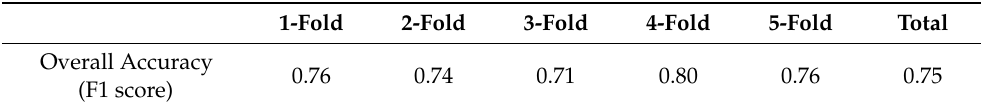
Table 2. Outcomes of five-fold validation for classification of three labels according to the vertical distance from the carina to the CVC